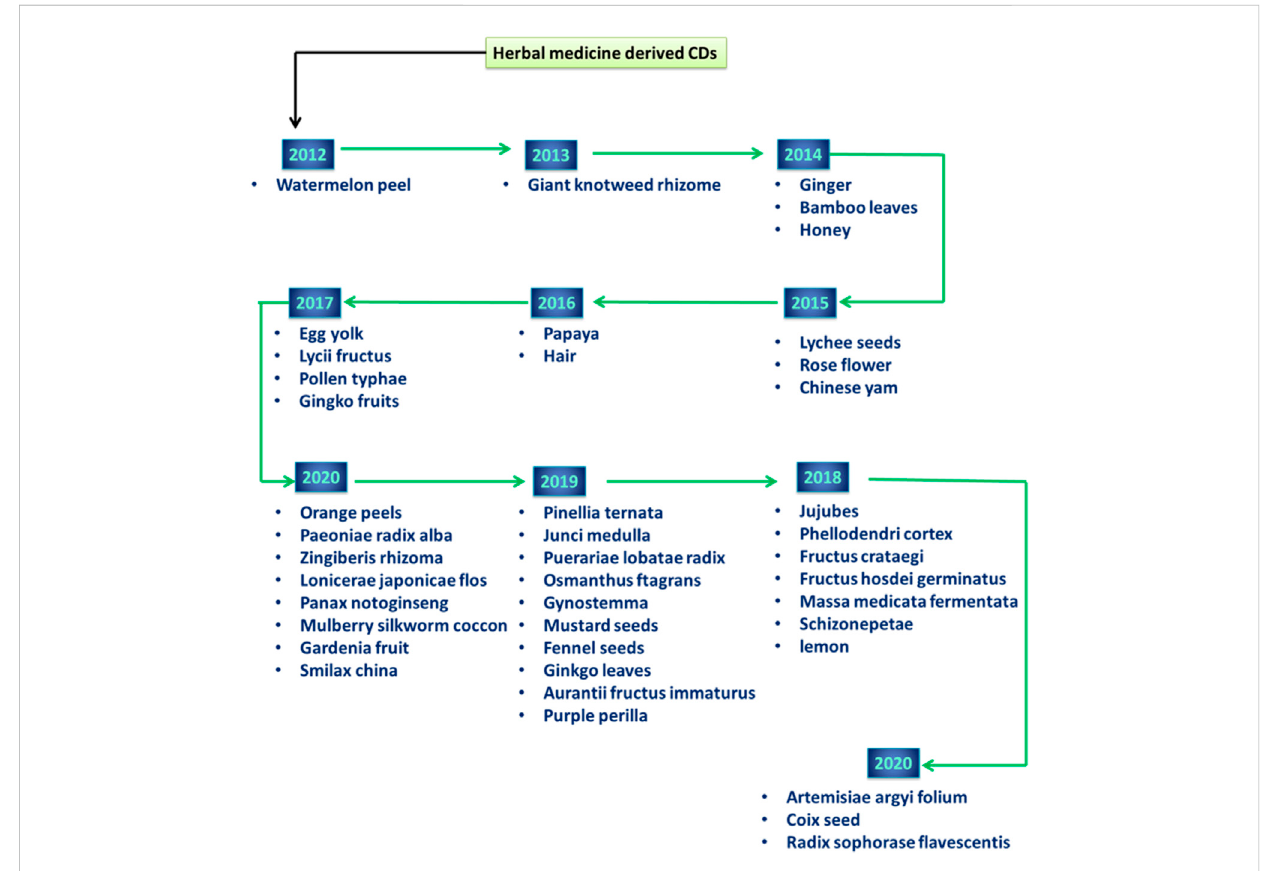
FIGURE 5 Timeline of herbal medicine derived